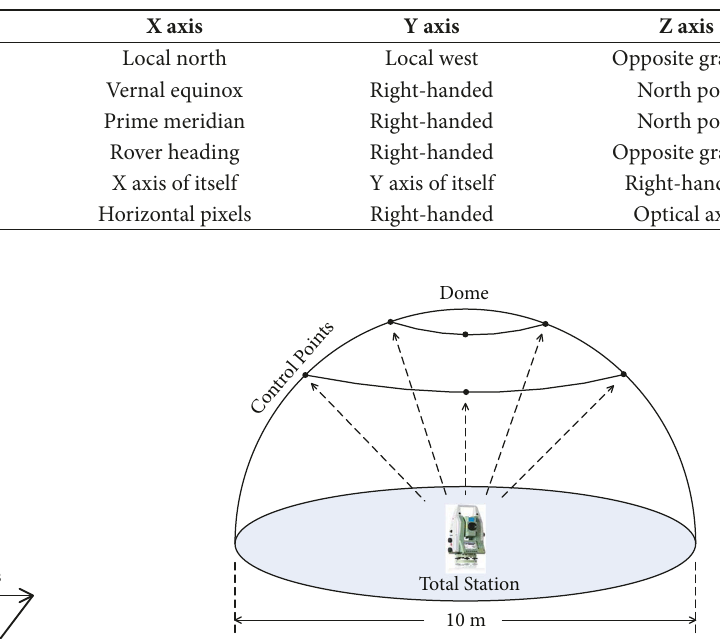
Table 1: Definition of main frames.